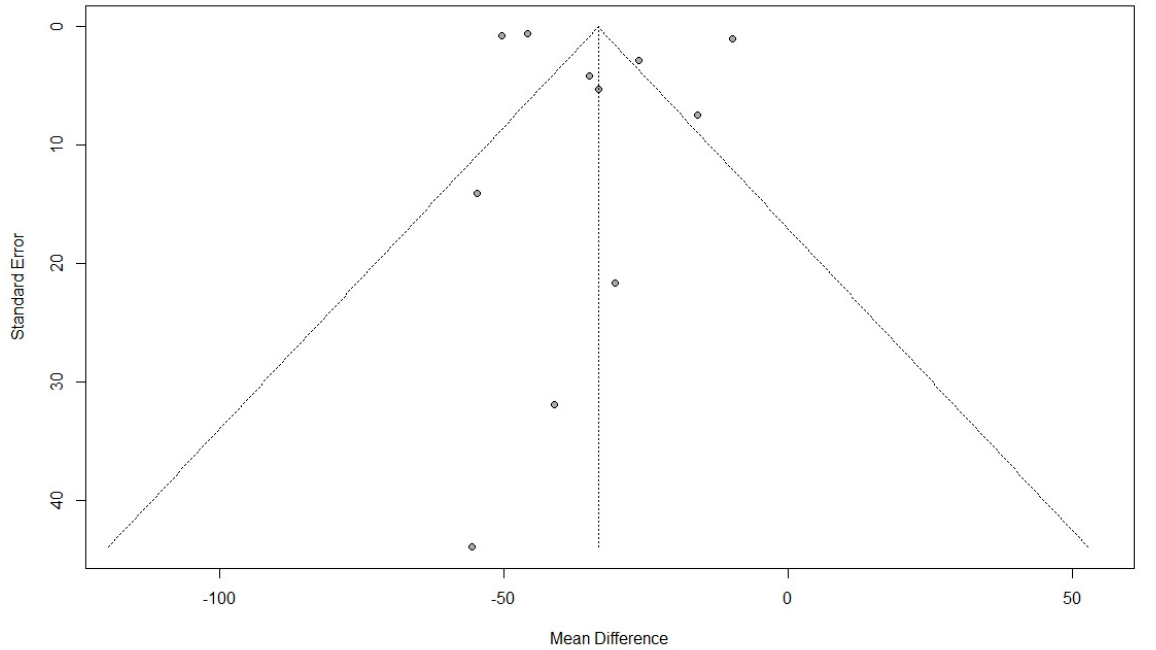
Figure 6. Funnel plot for the results of the effect of surgical intervention (vaginal and abdominal surgery) on total quality of life score using Pelvic Floor Impact Questionnaire (PFIQ).